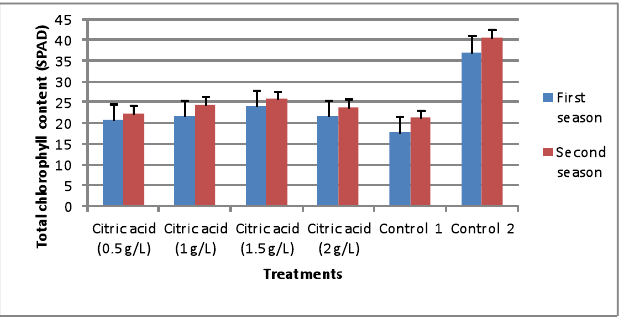
Fig. 2: Effect of different levels of citric acid on total chlorophyll content of leaves of bean plants subjected to drought stress conditions. Control 1: plants not treated by citric acid, but stressed. Control 2: plants not treated by citric acid and kept at field capacity during the entire experiments. Vertical bars present LSD value at